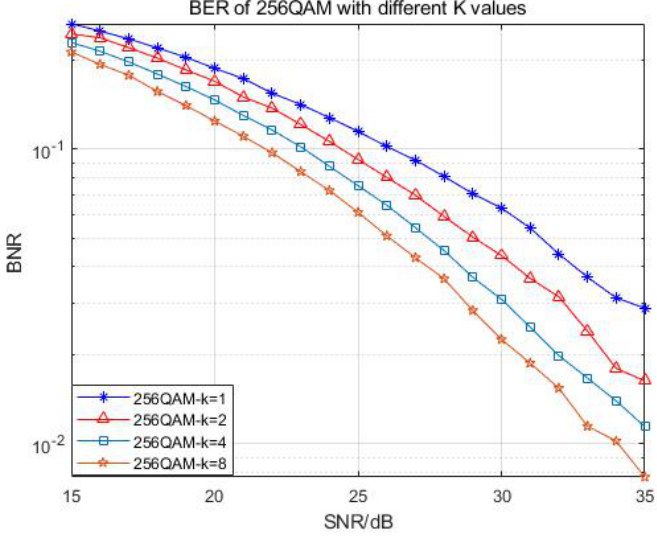
Figure 4. BER of 256-QAM demodulation with different K